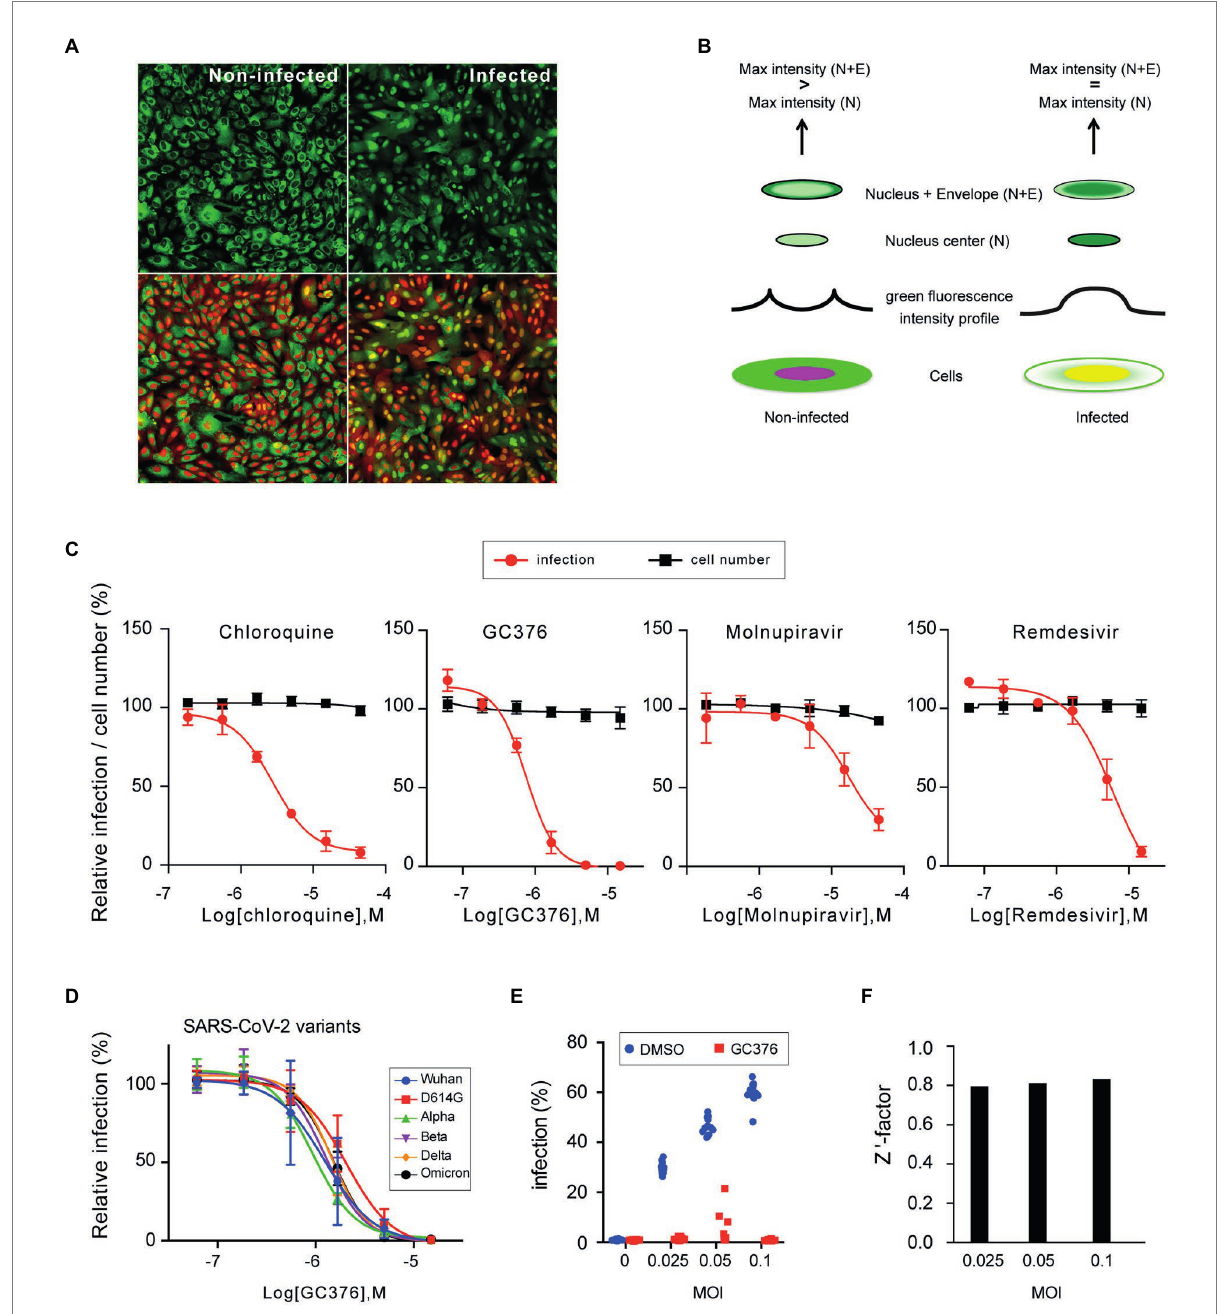
FIGURE 4 Characterization of the F1G-red reporter cell line in high-throughput format. (A) Images of individual fields of non-infected (left) and infected (right) F1G-red cells in 384-well plate format acquired using an InCell-6500 automated confocal microscope. The same fields are shown with GFP signal only (top) or with combined fluorescent signals (bottom). (B) Principle of automated quantification of SARS-CoV-2 infection. Cells are depicted with green and red signals, spatially separated in non-infected cells or combined in infected cells. The fluorescent intensity profile of GFP along an axis through the nucleus is schematically depicted above both cells. Above the intensity profiles, the pattern of green fluorescence in two areas, corresponding to the center of the nucleus (N) or to the nucleus and a ring of cytoplasm containing the nuclear envelope (N + E), are shown. Criteria for scoring infection versus non-infection are indicated on the top. (C) Antiviral dose–response experiments. F1G-red cells were infected with SARS-CoV-2 in the presence of indicated antivirals in 384-well plates and infection was measured at 16 hpi as explained in (B) . Relative infection rates (red line) and cell numbers (black line) normalized to DMSO controls are plotted (mean ± SEM of 3 (chloroquine and GC376) or 2 (remdesivir and molnupiravir) independent experiments). (D) GC376 dose–response experiments using the indicated SARS-CoV-2 variants of concern using F1G-red cells in 384-well plate format (mean ± SEM of 3 independent experiments). (E) F1G-red cells were infected with SARS- CoV-2 at different MOI in the presence of 10 μ M GC376 or 0.1% DMSO in 384-well plates and infection was measured at 16 hpi as explained in (B) . Individual values corresponding to 12 independent wells are plotted for each condition. (F) A robust Z’ factor based on the median of each series of measurements shown in (E) was calculated for each